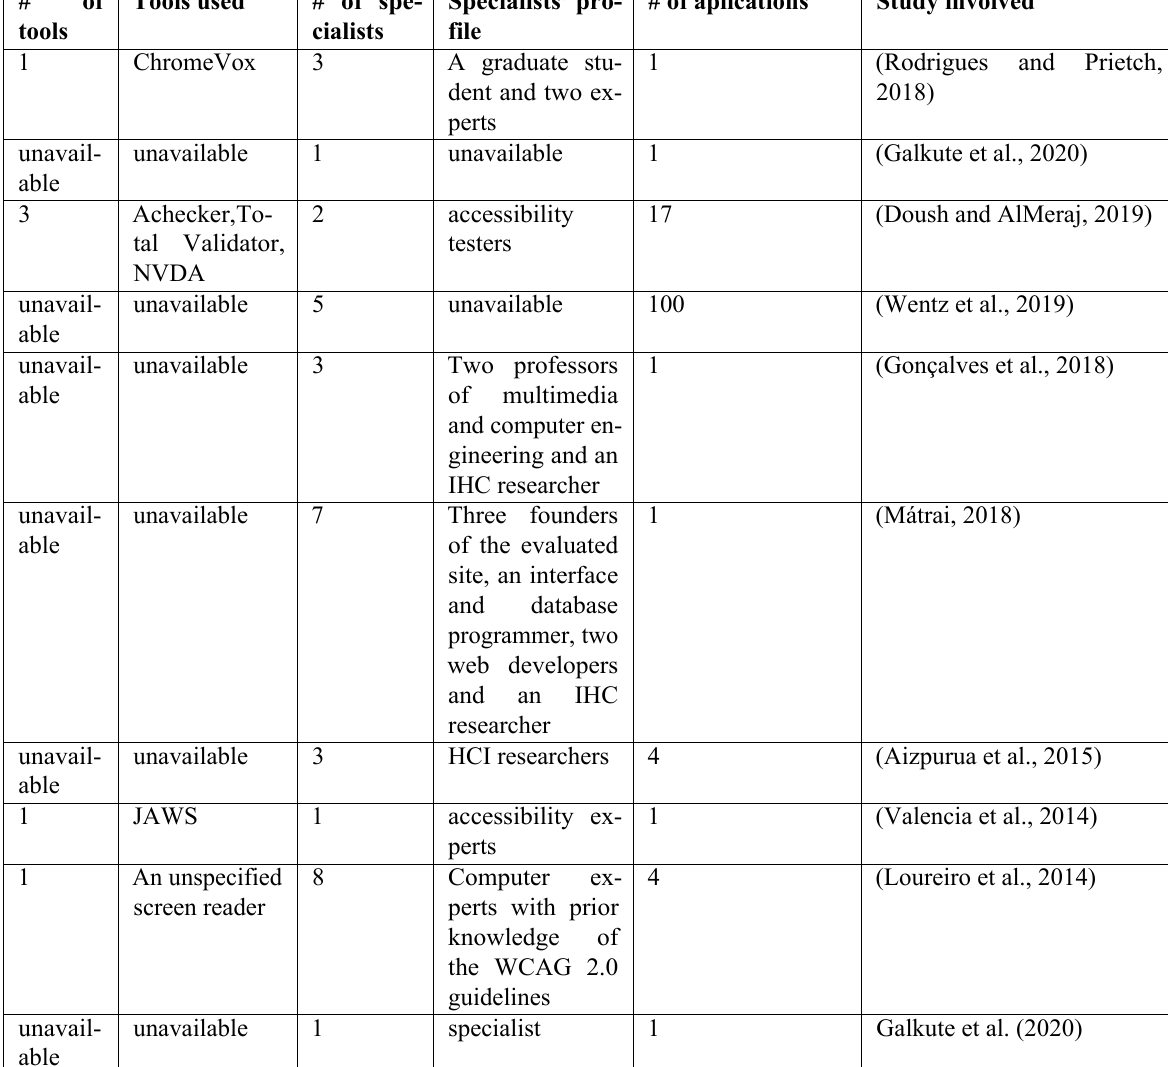
Table 4. Characteristics of accessibility inspections by specialists on websites.